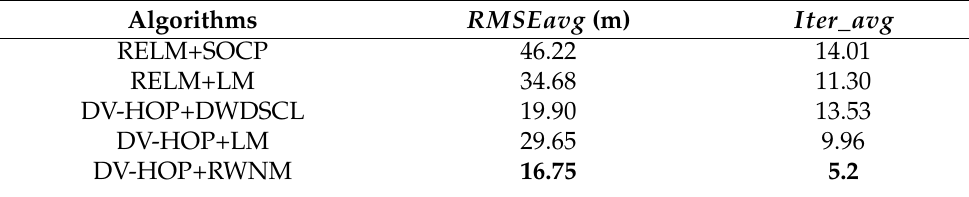
Figure 11. ( a ) RMSEavg and ( b ) Iter _ avg after running five iterative algorithms over 10 multi-hop anisotropic networks with R = 45 m and nfe = 0.3. Outliers levels are increased by steps of 10% from 0% to 50%. Table 9. RMSEavg and Iter _ avg at different levels of outliers Θ from 0% to 50%, R = 45 m and nfe = 0.3 under anisotropic networks, the best performances in RMSE average and iteration average are denoted in bold